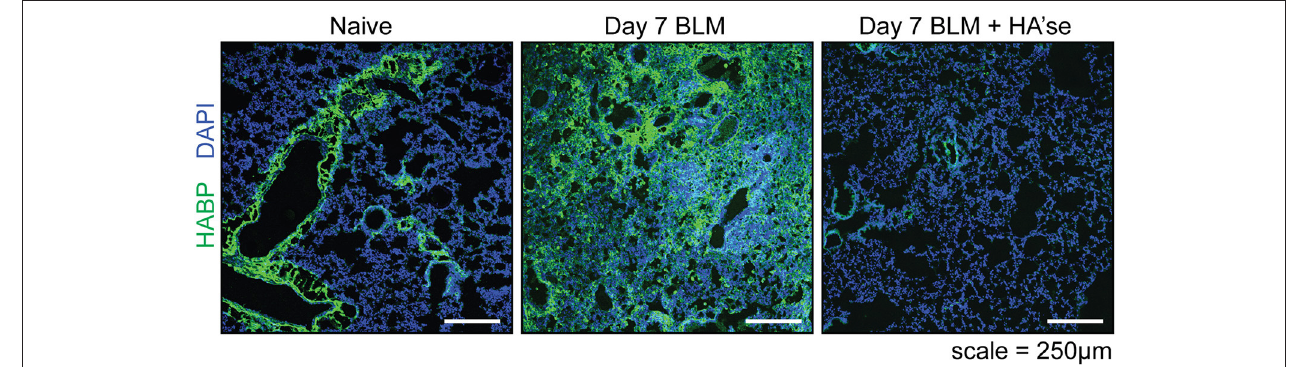
FIGURE 2 | Hyaluronan in the healthy and inflamed mouse lung. Frozen lung sections from CD44 + / + mice were labeled with HABP (green) to detect HA, and stained with DAPI (blue) to label cell nuclei. On the left is a representative image of the healthy (naïve) lung where HA is present on the major bronchioles and blood vessels, with little labeling in the interstitium. The middle panel shows HA present in the lung 7 days after bleomycin induced lung inflammation (Day 7 BLM). The panel on the right is a control, showing a lung section from day 7 BLM, after treatment with hyaluronidase. All images were captured using an Olympus FV1000 scanning laser confocal microscope under identical acquisition settings. These images are similar to data described in Cheng et al. ( 11), Hussell and Bell (13), and Sahu and Lynn